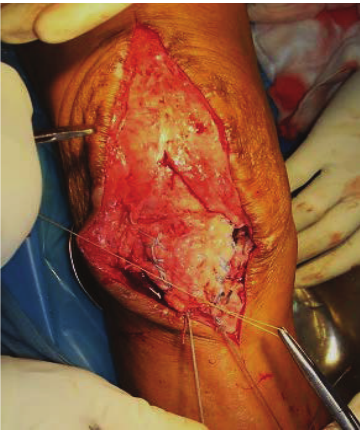
Figure 3: Showing fibre wire suture placed across both ends of patellar tendon.